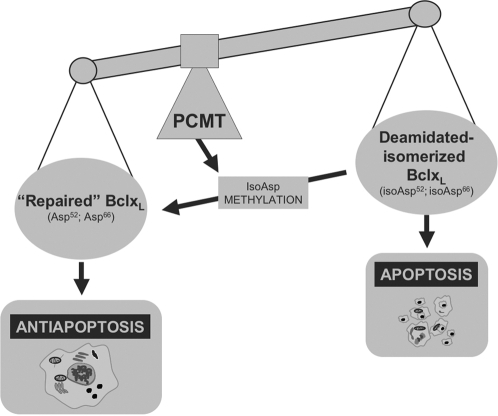
Proposed role of Bcl-xL deamidation and methylation in apoptosis.Deamidation-isomerization of two critical Asn residues of Bcl-xL abolishes its antiapoptotic function. Methylation of the same residues can restore the functional integrity of Bcl-xL through repair of the isopeptide bonds. Regulation of apoptosis toward antiapoptosis is gained through fine balancing of Bcl-xL deamidation and methylation.